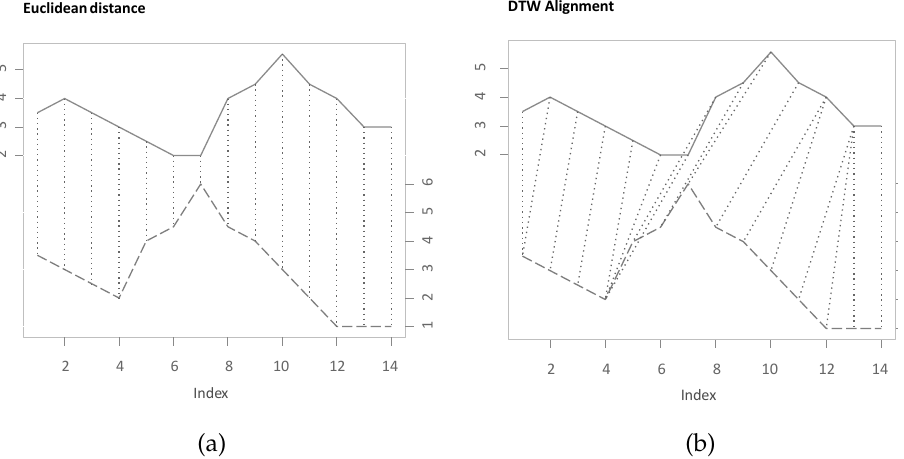
Figure 1. ( a ) Euclidean distance of the realizations of the two time series X and Y . ( b ) Dynamic Time Warping (DTW) alignment of the two time series X and Y